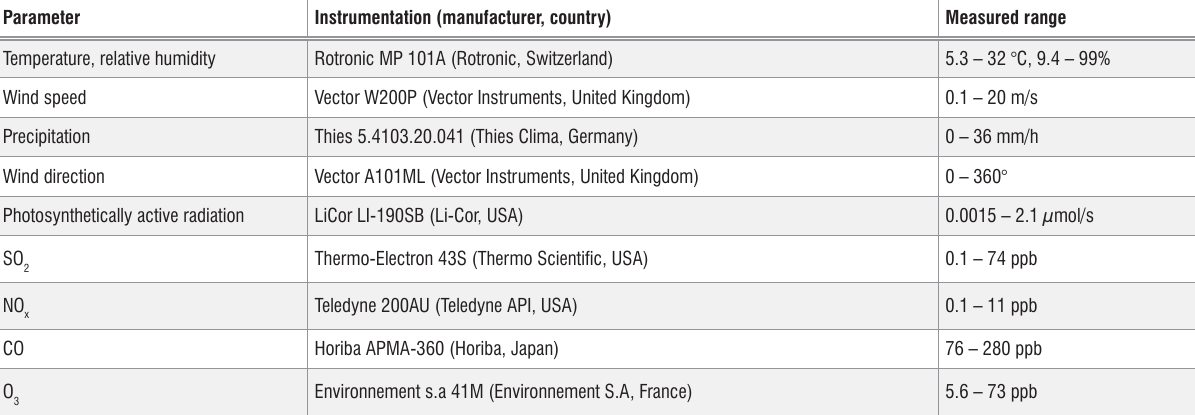
Table 1: Instruments used for measuring meteorological parameters and trace gas concentrations at the Botsalano Game Reserve. The range of values measured during October 2007 are presented to describe the characteristics of the savannah environment. Parameter Instrumentation (manufacturer,